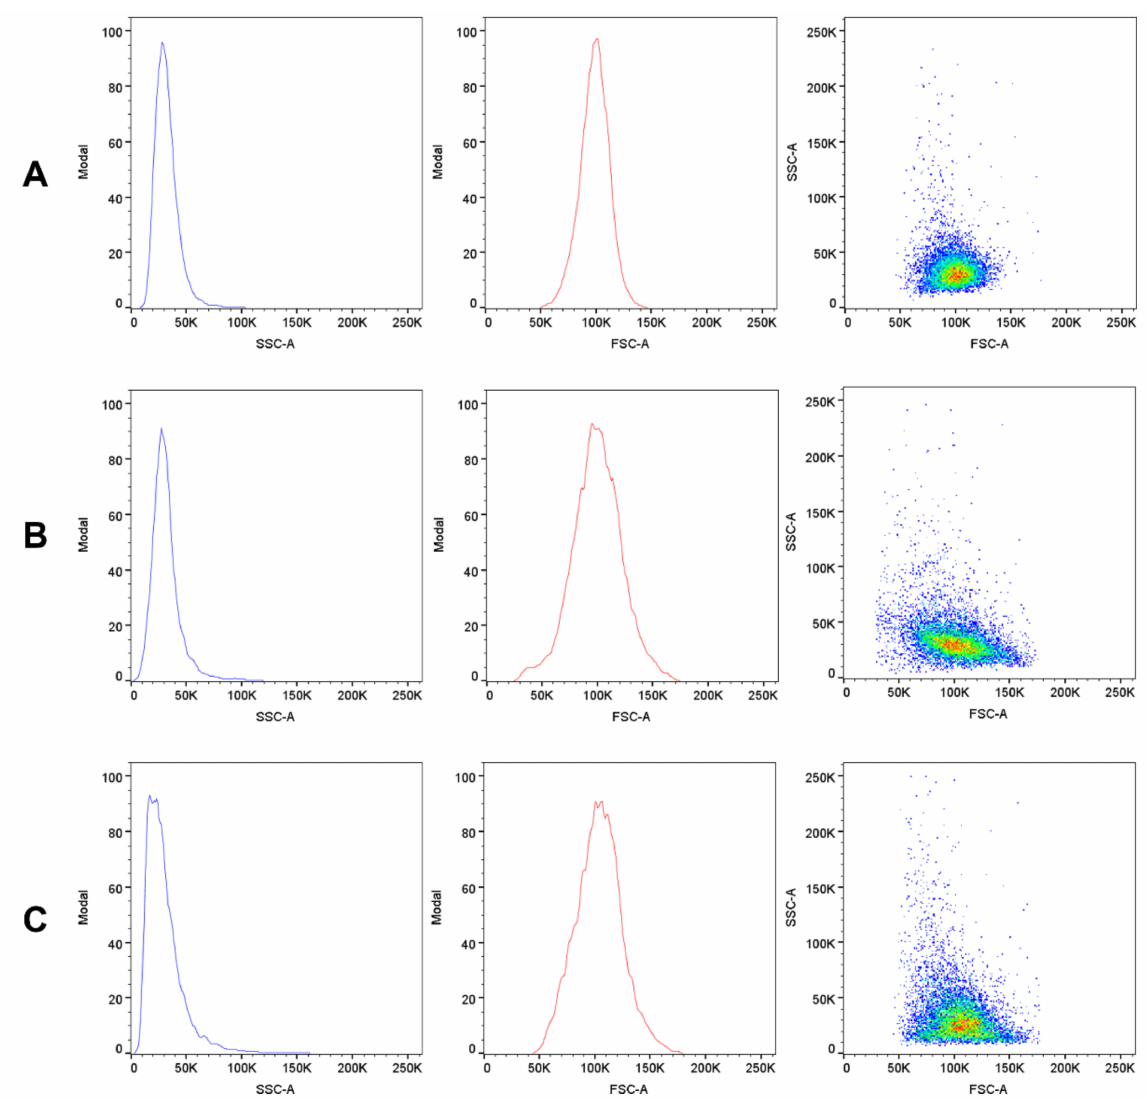
Figure 17. Scattering diagrams of human control erythrocytes ( A ), erythrocytes incubated with TBBPS at 100 µ g/mL ( B ) and erythrocytes incubated with TBBPA at 25 µ g/mL ( C ) for 48 h. The FSC-A diagrams represent the light scattered near the forward direction (proportional to the value of the particles). The SSC-A diagrams represent scattering at a right angle (depended on cell shape and internal properties). The FSC-A/SSC-A diagram is a dual parameter contour plot proportional to the total cell diversity.